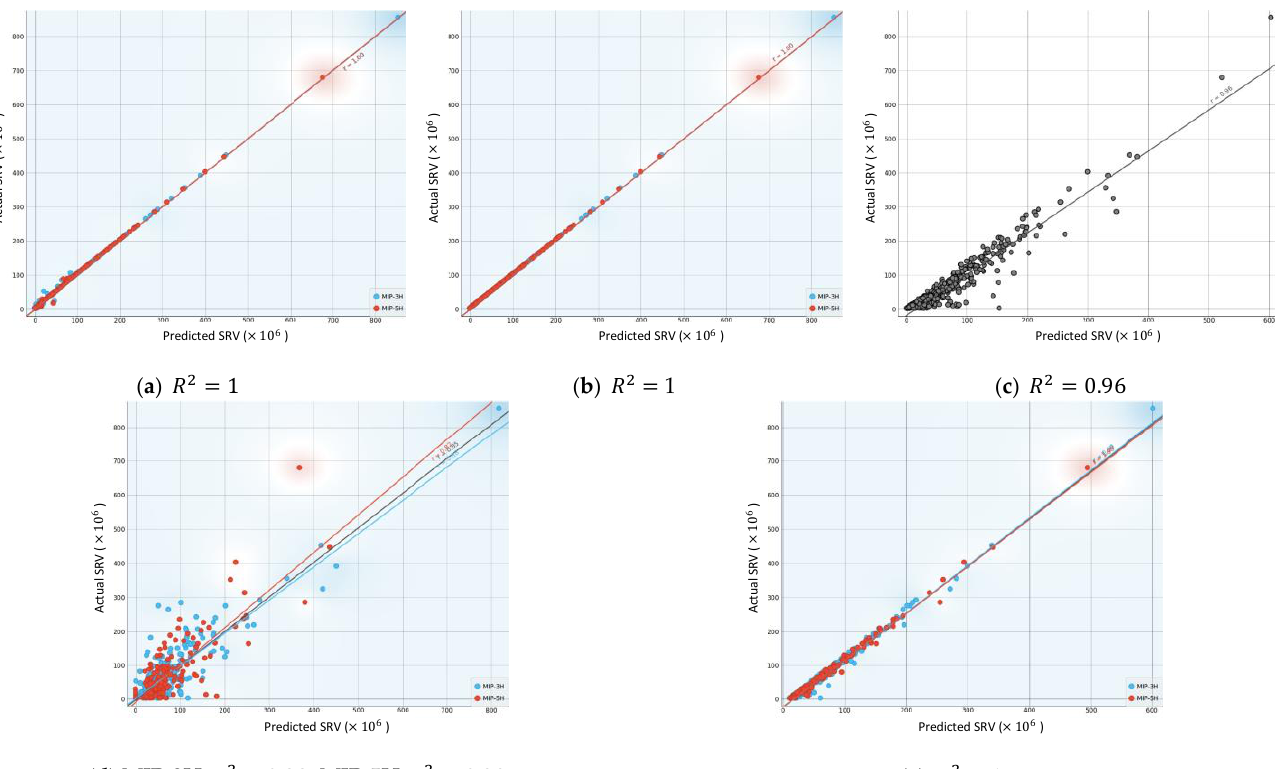
Figure 11. The model performances on the training data. ( a ) AdaBoost, ( b ) KNN, ( c ) Random Forest, ( d ) ANN, and ( e ) Stack. The x -axis in the plots shows the predicted values by the models, and the y -axis represents the actual values.